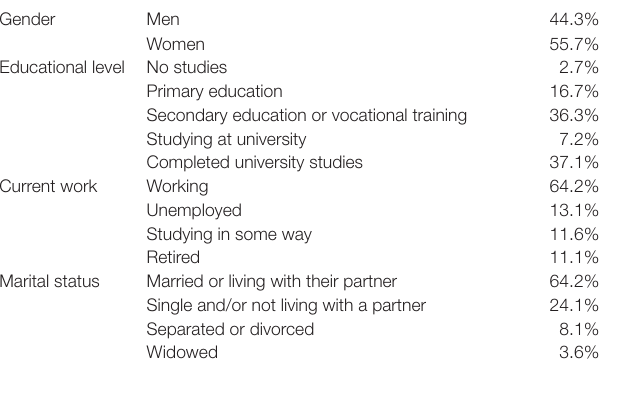
TABLE 1 | Percentage of sociodemographic